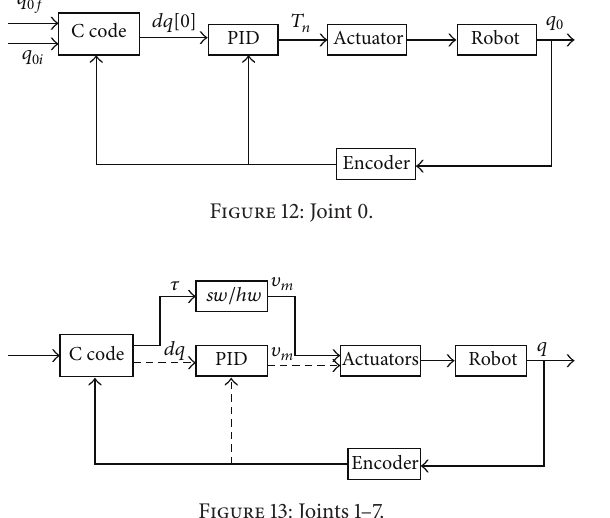
Figure 13: Joints 1–7.